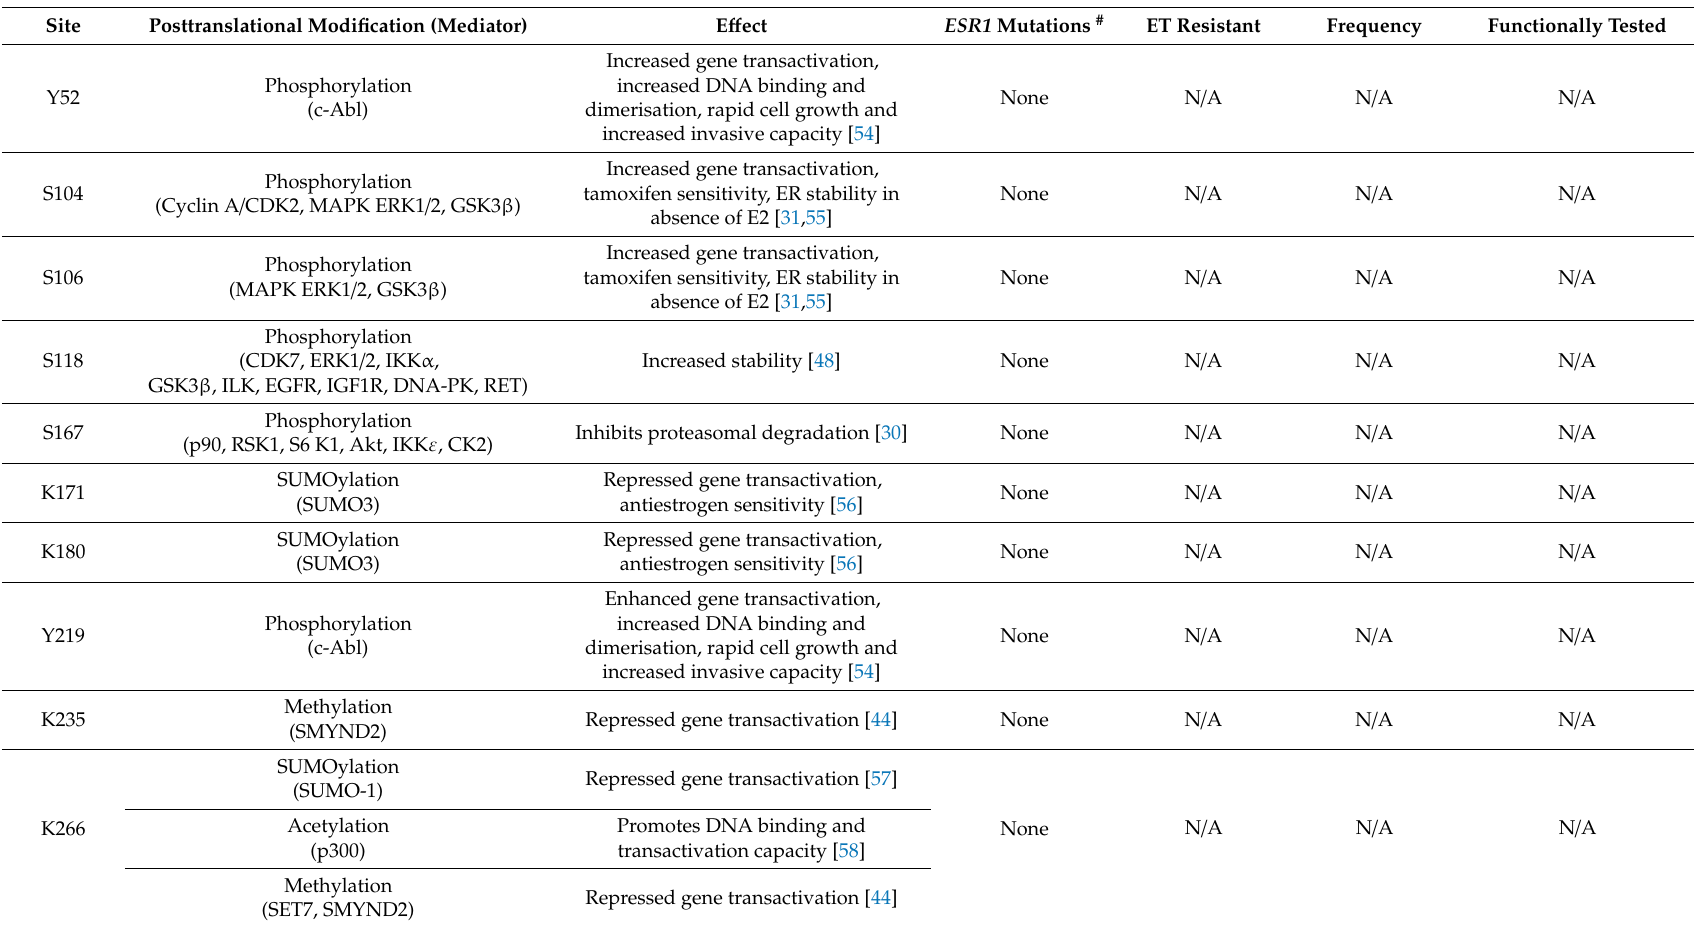
Table 1. ER Posttranscriptional Modification Sites and E ff ects of